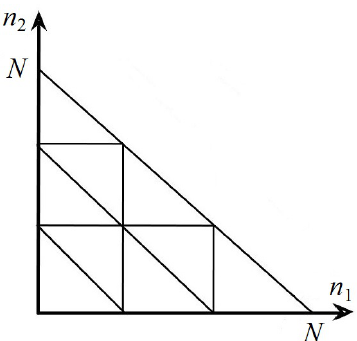
Figure 5. Undirected graph Γ , representing network G with failures at critical level N for total number of customers in the network G .